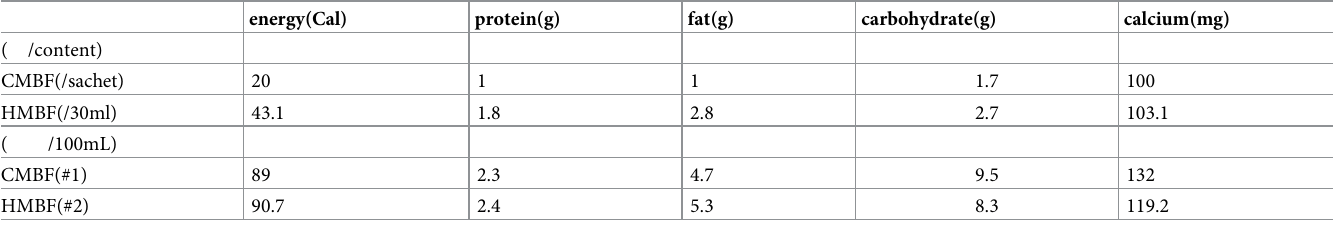
Table 1. Contents in unfortified/fortified HM.